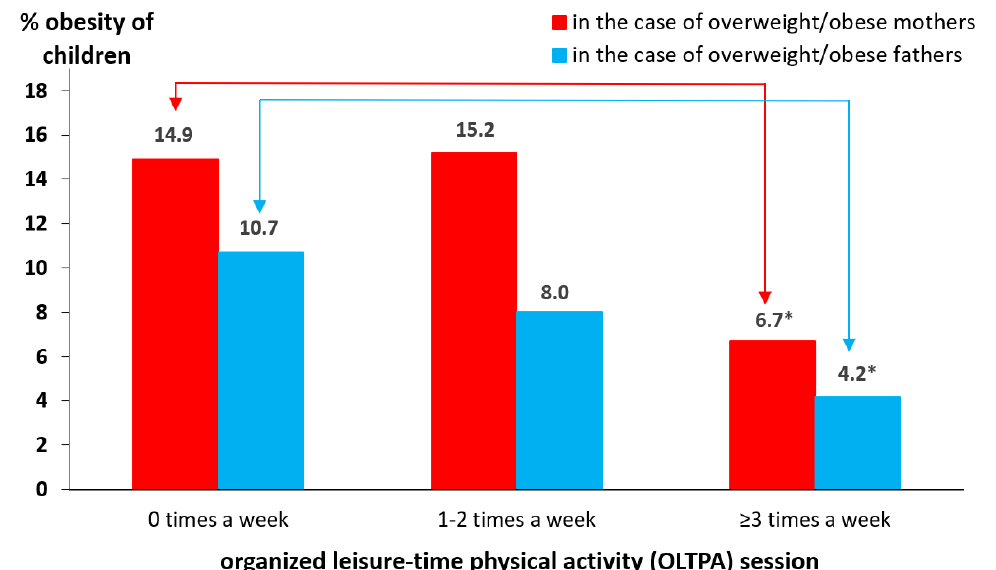
Figure 3. The prevalence of obesity in children of overweight and obese parents regarding the participation of offspring in organized leisure-time physical activity (* statistically significant differences between participation 0 and ≥ 3 times a week in organized leisure-time physical activity based on the Chi-square tests, p < 0.002 ).